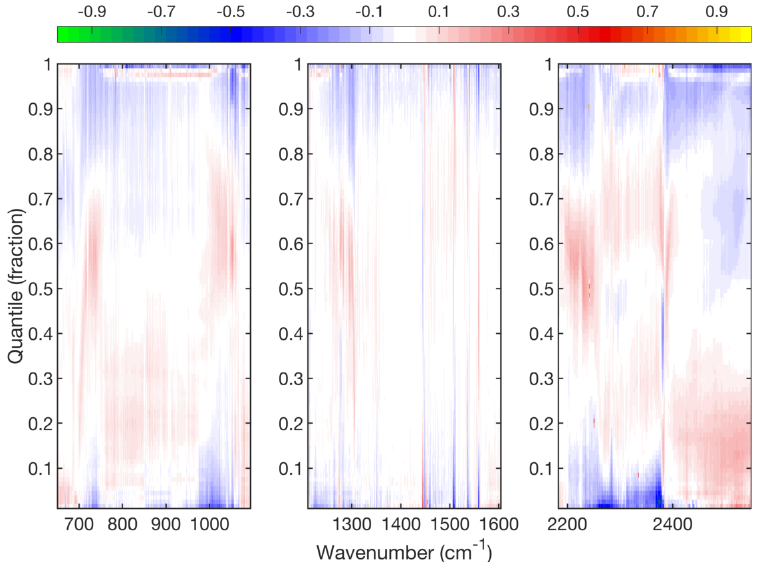
Figure 12. CHIRP-AQ cumulative probability quantile values minus the CHIRP-SN quantiles. Color scale is in ∆ BT. Note that window channels in the higher quantiles (0.97) are hotter for AIRS, then turning colder in the last few quantiles. This may be due to CrIS’s slightly smaller field-of-view which leads to slightly more observations of very hot